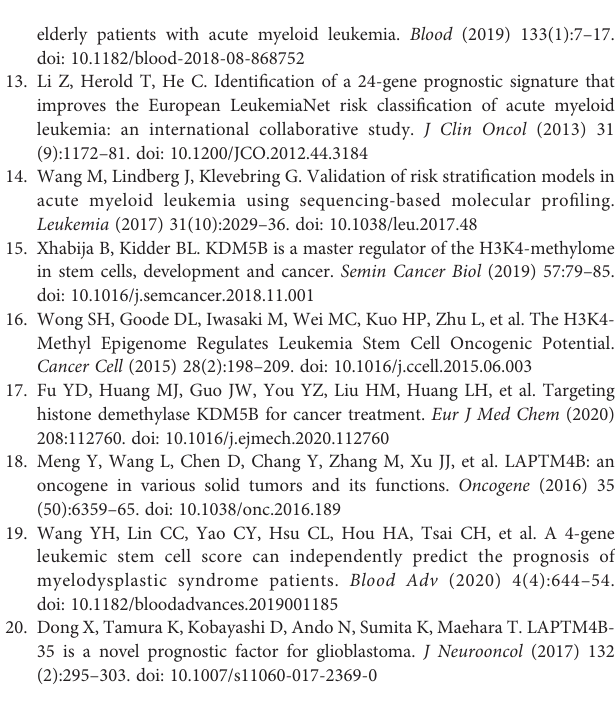
Supplementary Table 1 | Characteristics of the different random forest models created at the different signi fi cance thresholds. Error rates (1-concordance) are provided for predictions of survival at 1, 2, 3, 4, 5 and full follow-up periods. Supplementary Table 2 | Variables included in the fi nal model along with their relativeimportance.Forgeneexpressionprobes,wealsoreportthetypeofinputused (either continuous gene expression counts or Mclust -based binary